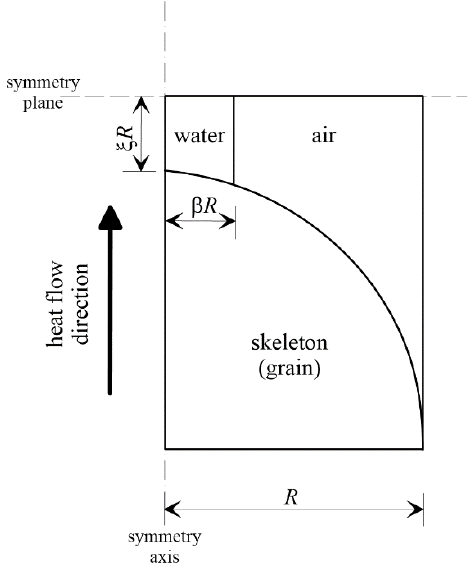
Figure 5: Assumed geometry of a three-phase medium (Haigh,